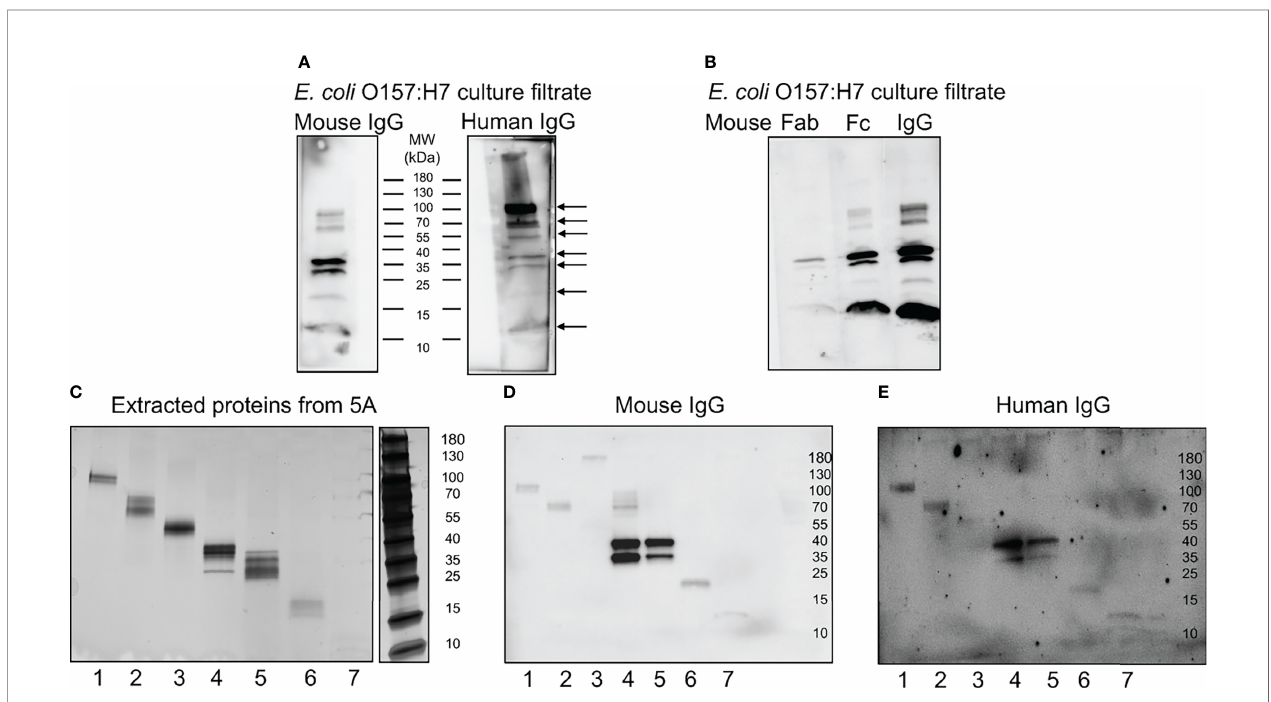
FIGURE 5 | Mouse and human IgG bind speci fi c E . coli O157:H7 proteins. E. coli O157:H7 proteins in culture fi ltrate were blotted onto membranes for detection of IgG binding. (A) E. coli O157:H7 proteins incubated with mouse IgG and human IgG. The blot detected with mouse IgG shows six bands and the blot detected with human IgG shows seven bands (arrows). Both lanes were run on the same gel. (B) E. coli O157:H7 proteins detected with mouse Fab, Fc and whole IgG showing that the binding to E. coli O157:H7 proteins is mediated via the Fc fragment. All lanes were run on the same gel and visualized by immunoblotting. (C) Silver stained gel of eluted proteins corresponding to the seven E. coli O157:H7 proteins detected with mouse and human IgG in panel (A) . (D) Immunoblot of eluted proteins [according to panel (C) ] detected with mouse IgG. (E) Immunoblot of eluted proteins [according to panel (C) ] detected with human IgG. A faint band in lane 3 was not seen in (D) . MW, molecular